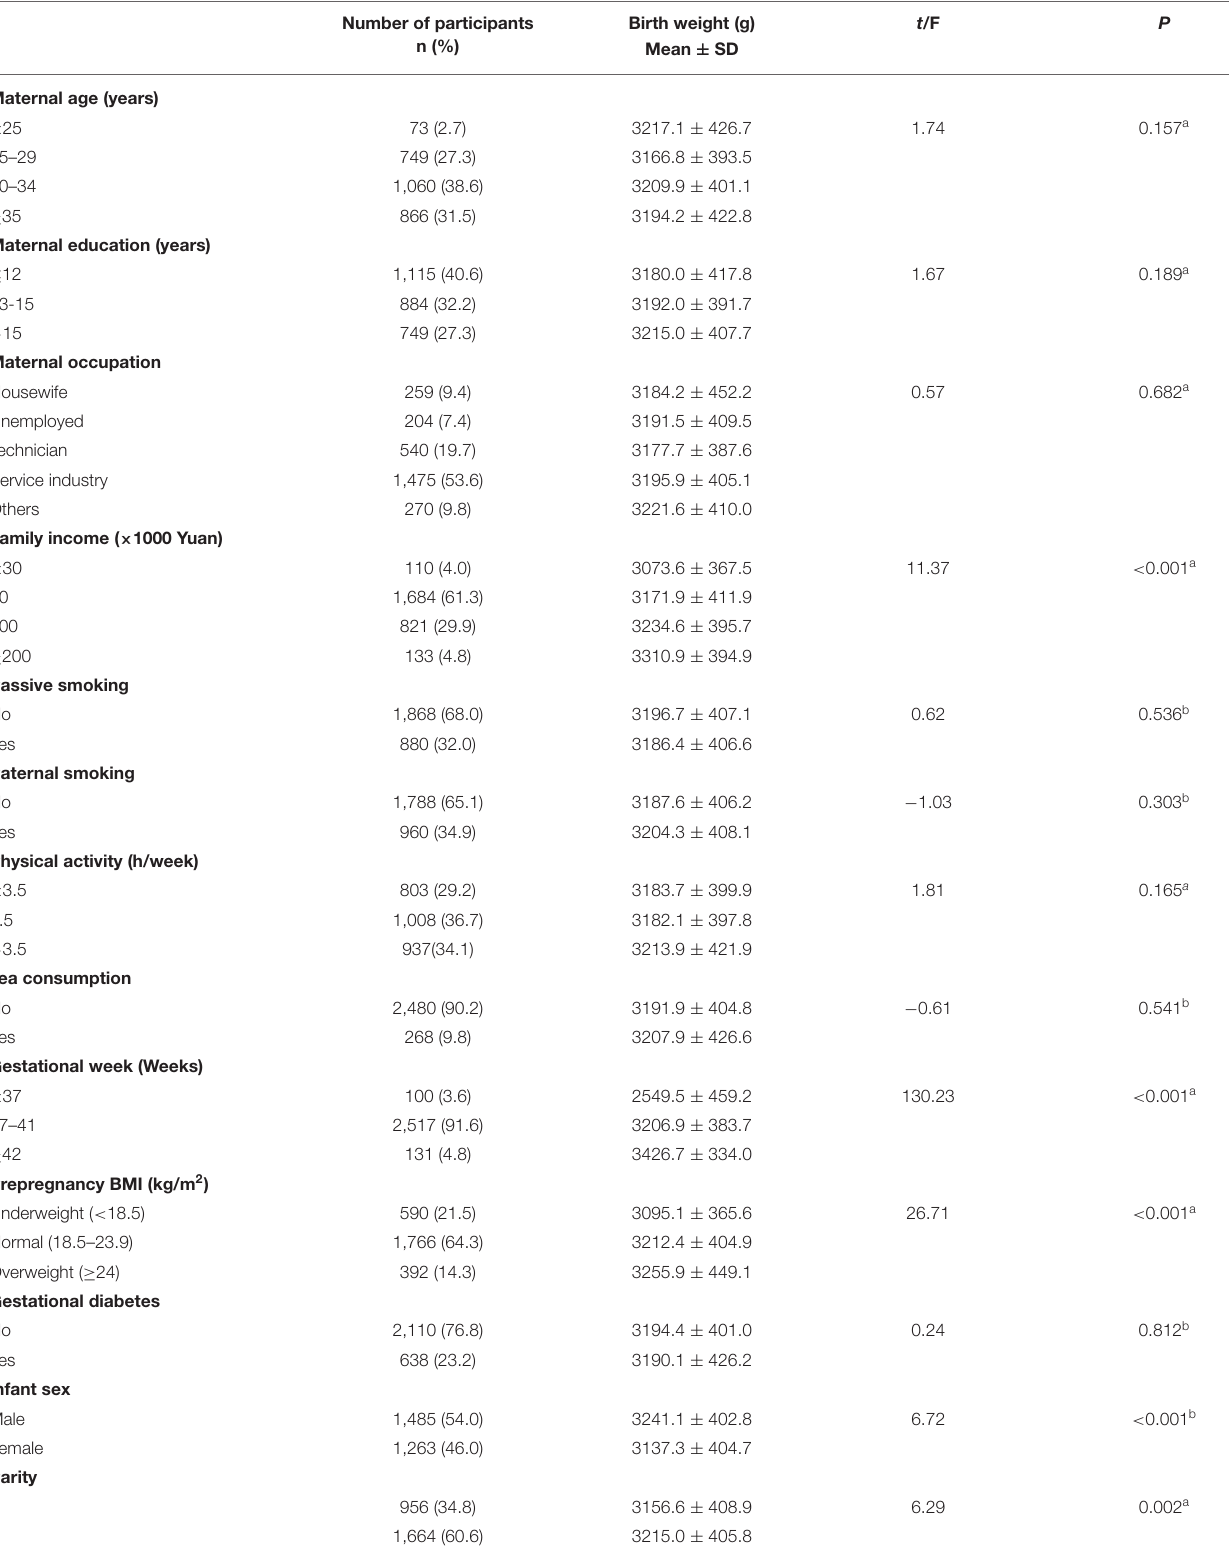
TABLE 1 | General characteristics of